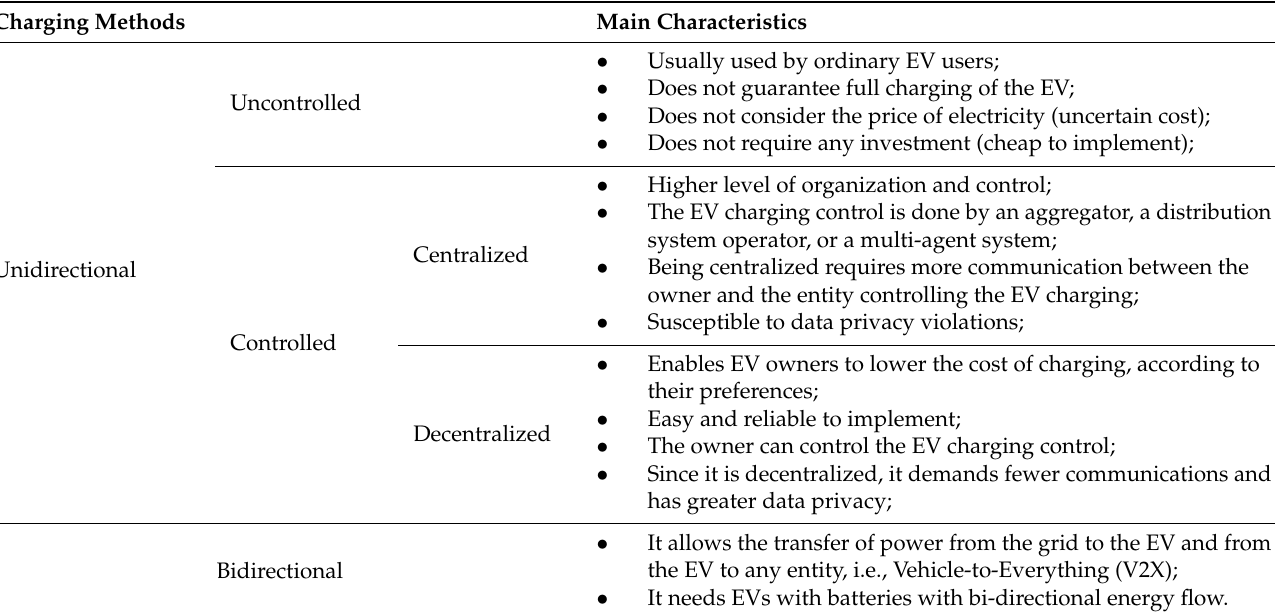
Table 4. Different Charging